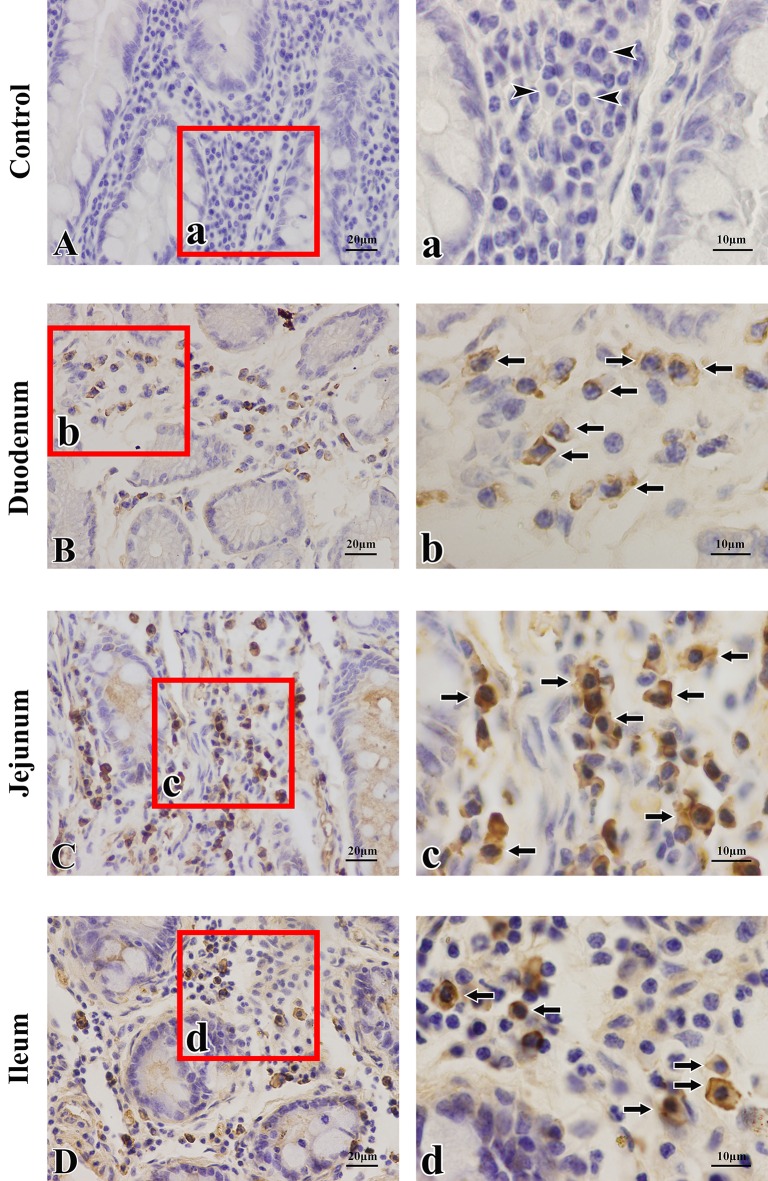
Immunohistochemical staining of SIgA antibody-secreting cells in the intestine of young Bactrian camels.(A) Negative control (lamina propria (LP) of the jejunum, with triangles indicating plasma cells). (B) Distribution of SIgA antibody-secreting cells (ASCs) in the duodenal LP. (C) Distribution of SIgA ASCs in the jejunal LP. (D) Distribution of SIgA ASCs in the ileal LP. SIgA ASCs were scattered in the small intestinal LP, and some cells aggregated around the crypts. Arrows indicate SIgA ASCs. Small pictures (a-d) are representative views from the four sublocations (original magnification: left column = 400×, right column = 1000×).